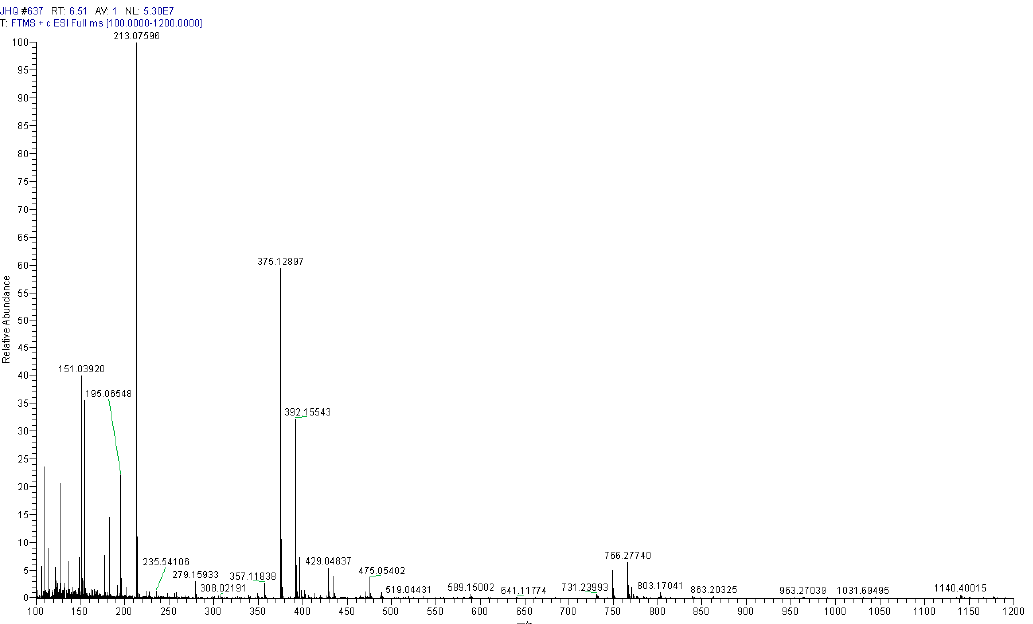
Figure 4. The Q Exactive Hybrid Quadrupole-Orbitrap-MS spectrum of compound S in positive mode.